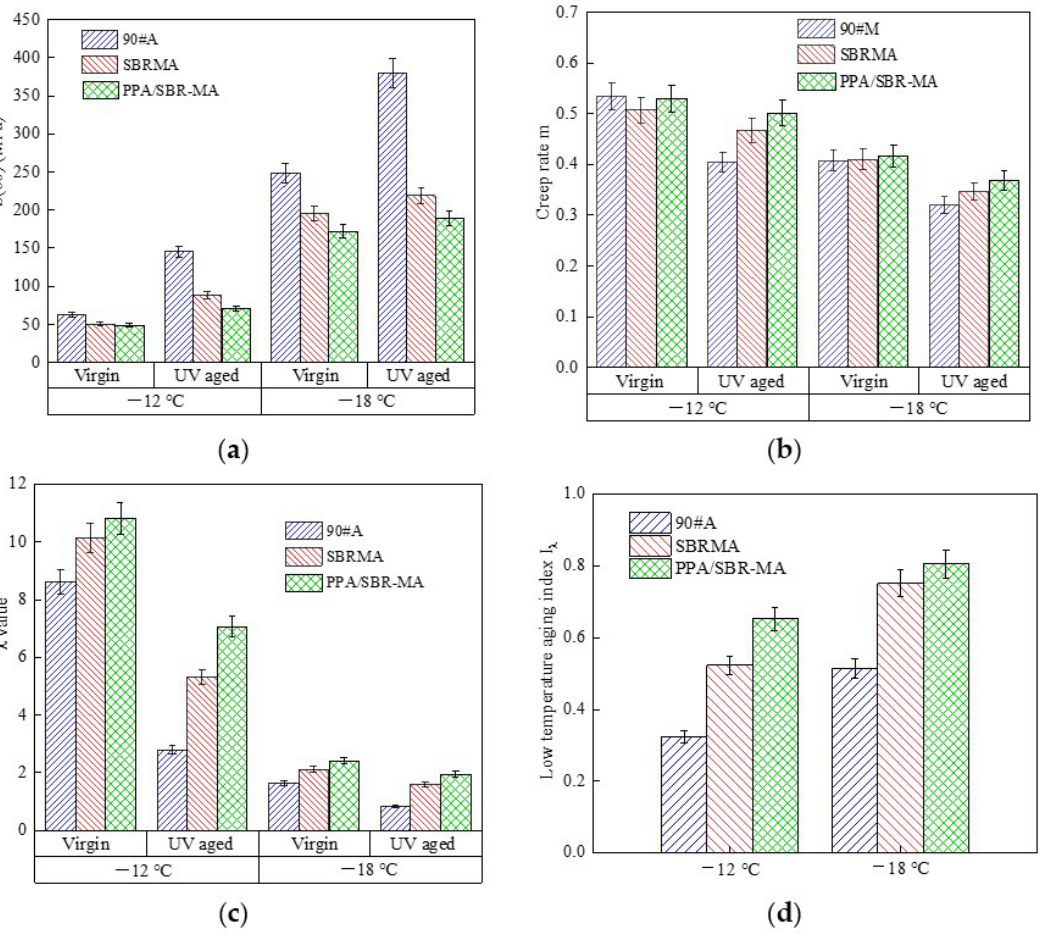
Figure 7. Low temperature rheological properties results. ( a ) Stiffness Modulus S(60); ( b ) Creep rate m; ( c ) The ratio λ ; ( d ) Low temperature aging